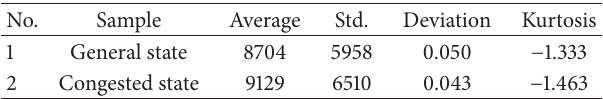
Table 4: Results of statistical analysis on the average saccade acceleration.